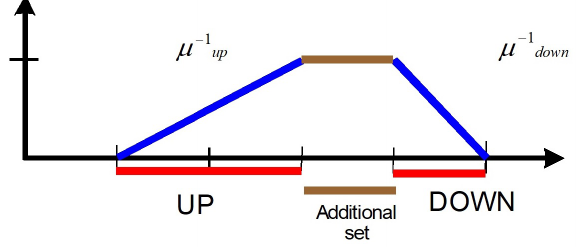
Figure 2. A fuzzy representation of Ordered Fuzzy